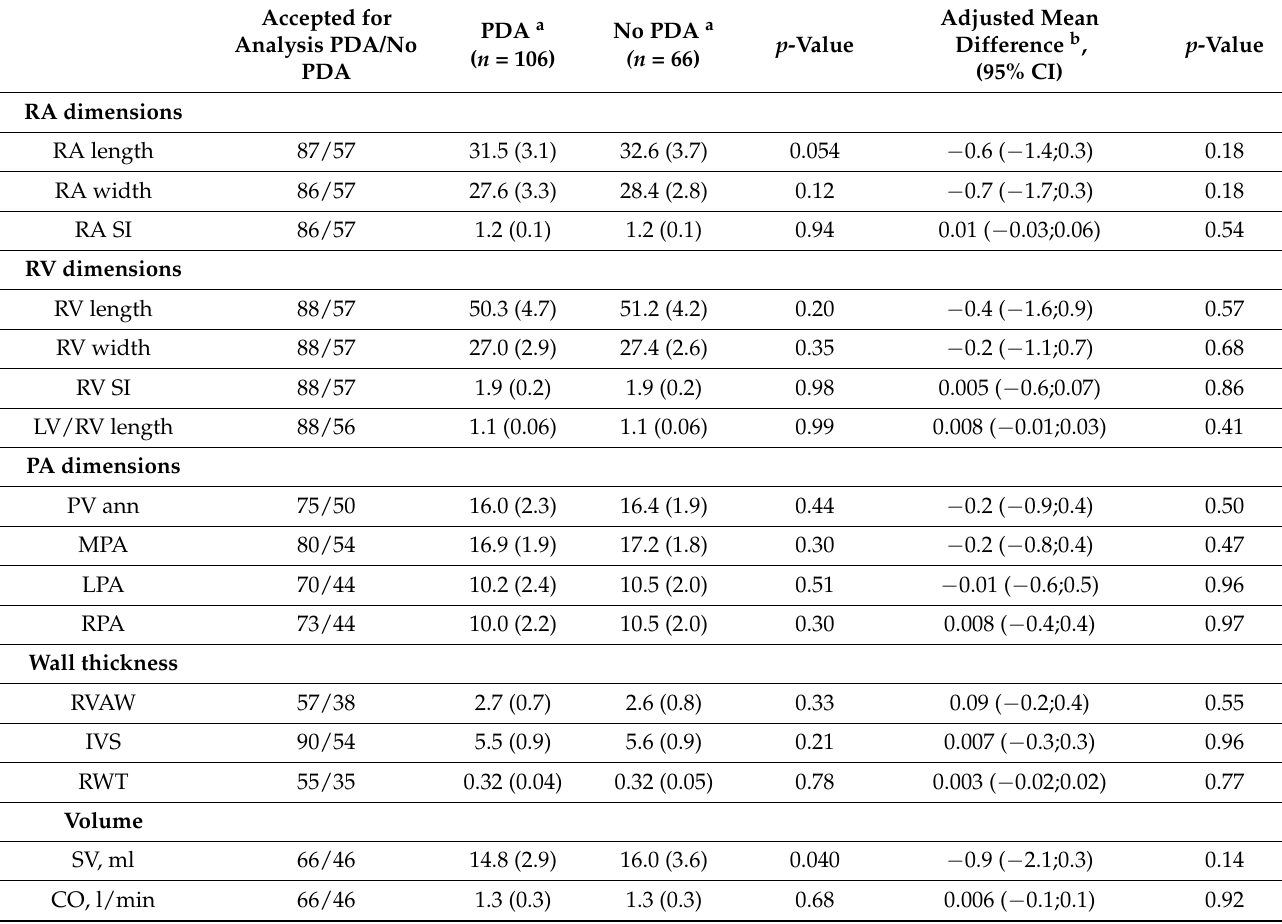
Table 4. Right heart dimensions and volumes in 6.5-year-old children born extremely preterm (EXPT) stratified by a neonatal treated patent ductus arteriosus